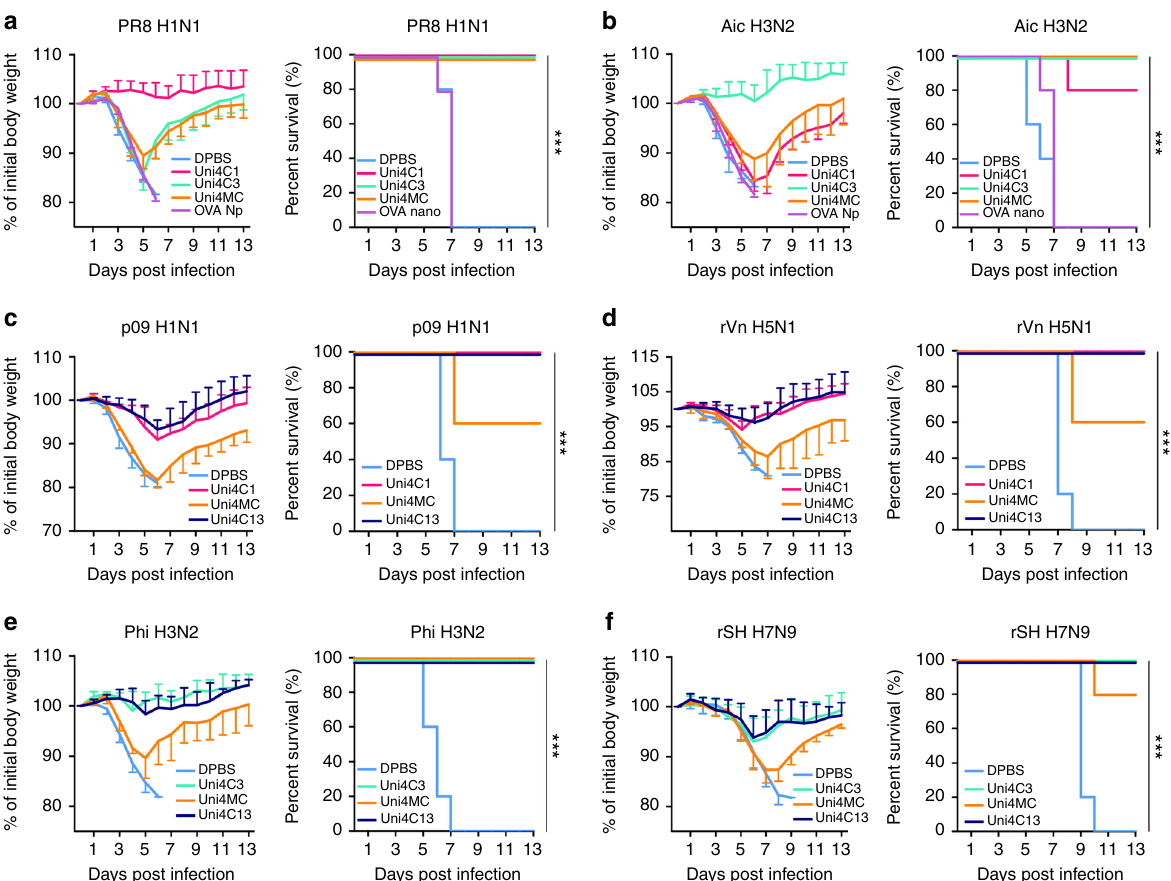
Fig. 3 PNp protective ef fi cacy in mice. Mean body weight changes and survivals upon lethal dose challenges. Error bars represent mean ± SD and statistical analysis was performed with a log-rank test (*** p < 0.001, n = 5). For viral challenges, mice were slightly anesthetized by inhalation of iso fl urane, and a dose of 6 mLD 50 virus in 50 μ l PBS was dropped into two nares. Mouse body weight changes and survivals were monitored for 2 weeks. a PR8; b Aic; c p09; d reassortant Vtn (rVn); e Phi; and f reassortant SH